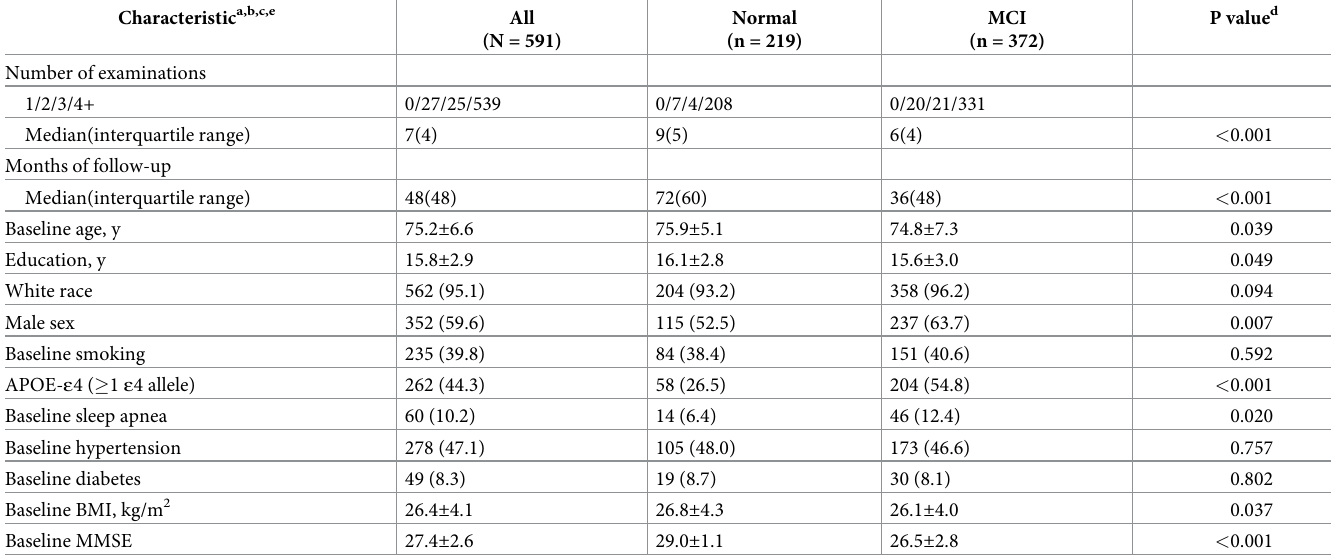
Table 2. Characteristics of ADNI1 participants by cognitive